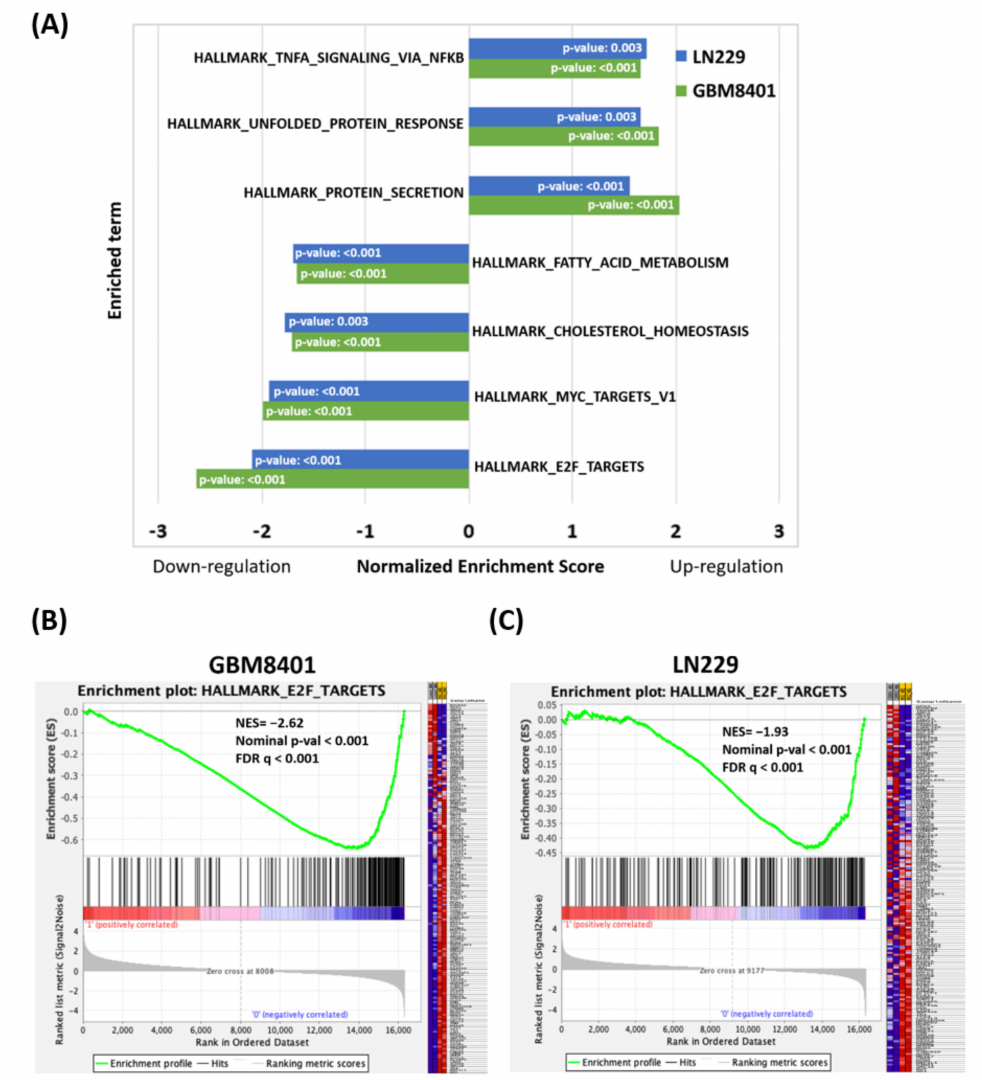
Figure 6. ( A ) Gene set enrichment analysis (GSEA) of the most upregulated and downregulated diosmin-induced phe- notypes in GBM8401 and LN229 cells treated with 160 µ M of diosmin for 48 h. ( B , C ) Enrichment analyses of the most downregulated signal pathway “E2F_targets” in diosmin-treated GBM8401 ( B ) and LN229 ( C ) cells. NES, normalized enrichment score; FDR, false discovery